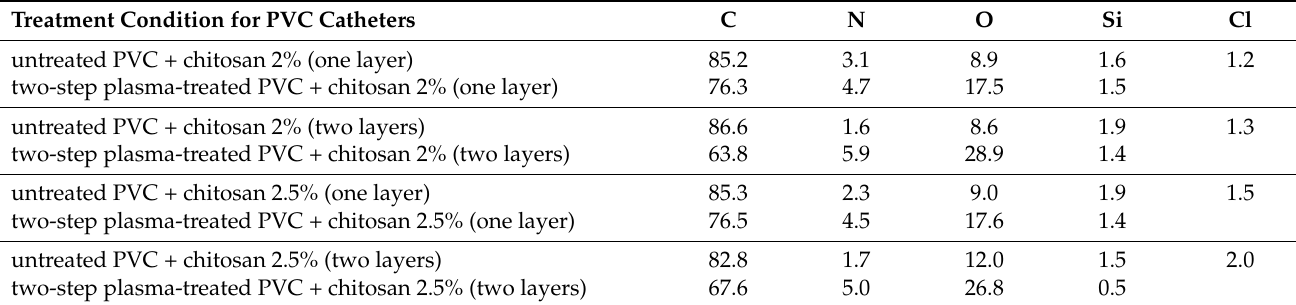
Table 7. XPS composition of PVC catheters with the coating (in atomic %).